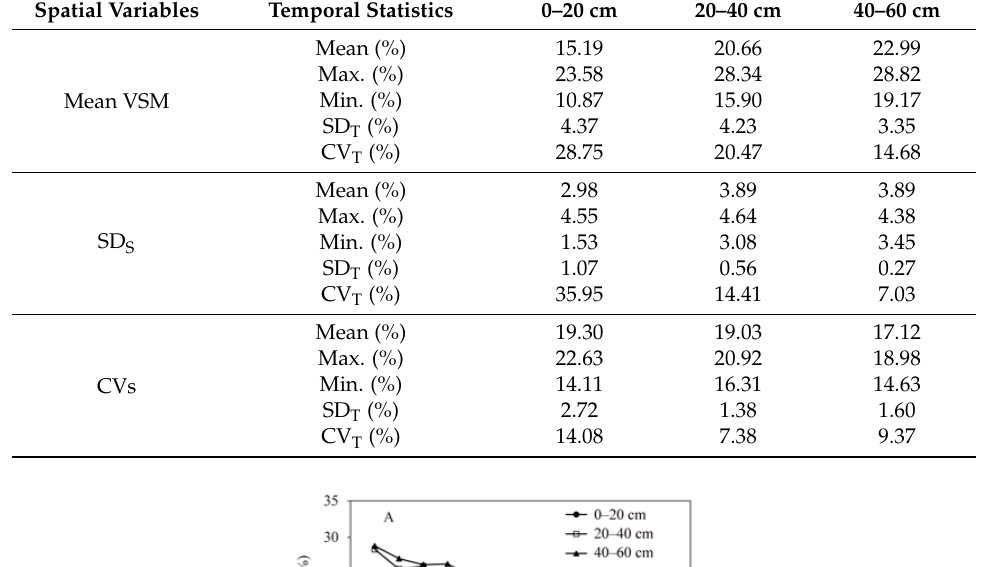
Table 2. The temporal statistics of slope (spatial) means of volumetric soil moisture (VSM) and associated coefficients of variation (CVs) and standard deviations (SDs) for three soil layers.